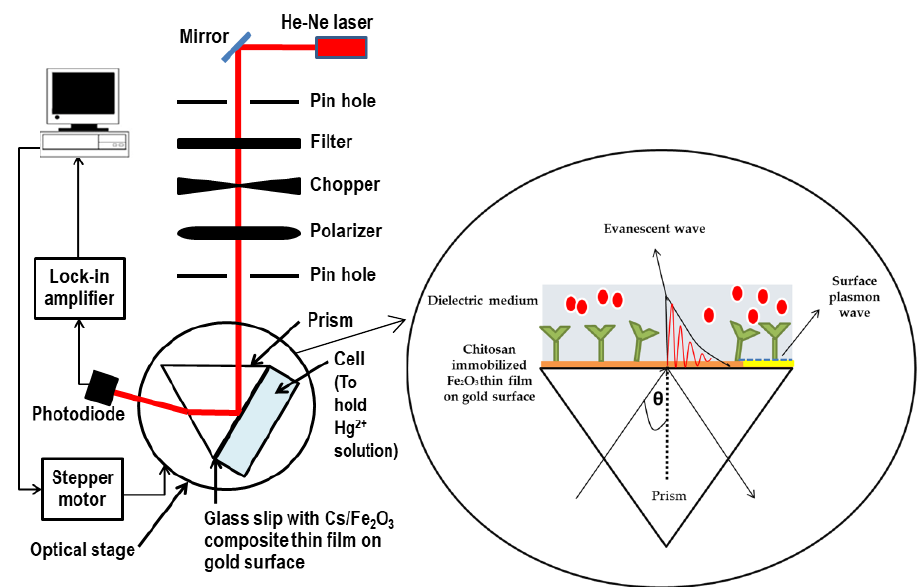
Figure 1. Optical setup of surface plasmon resonance spectroscopy.